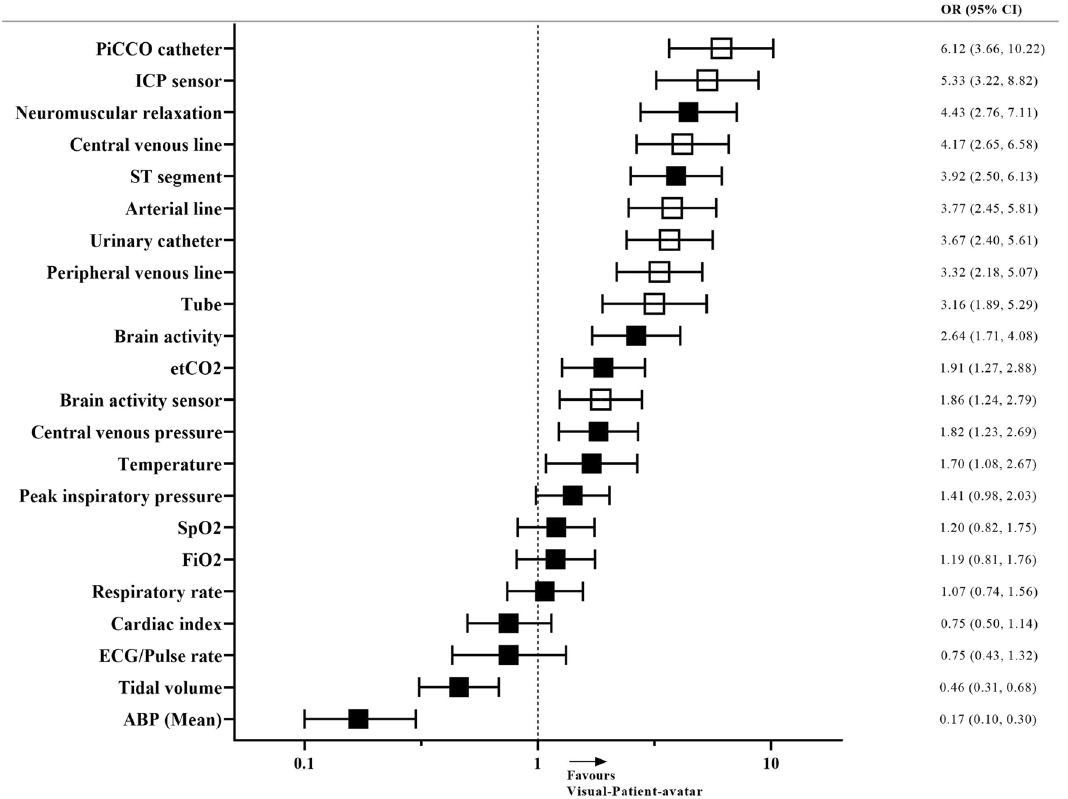
Figure 3. Matched odds ratios of the different vital signs and installations for Visual-Patient-avatar ICU and conventional monitor. Odds ratios (OR) are presented by boxes and whiskers indicate the 95% confidence interval. Filled boxes represent vital signs, while empty boxes illustrate installations. ICP Intracranial pressure,